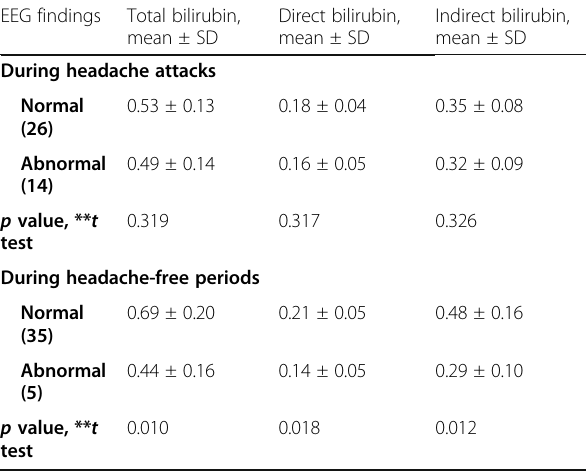
Table 5 The relationship between serum bilirubin concentration results and EEG findings during both headache attacks and during headache-free periods (at least 2 days after the most recent attack) EEG